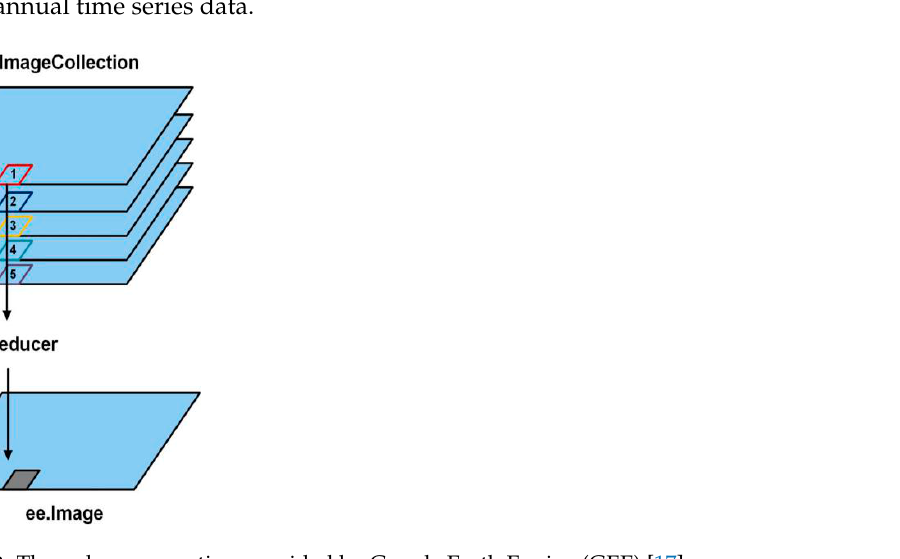
Figure 3. The reducer operation provided by Google Earth Engine (GEE) [17]. Table 2. Some functions of reducer operation provided by GEE [17].